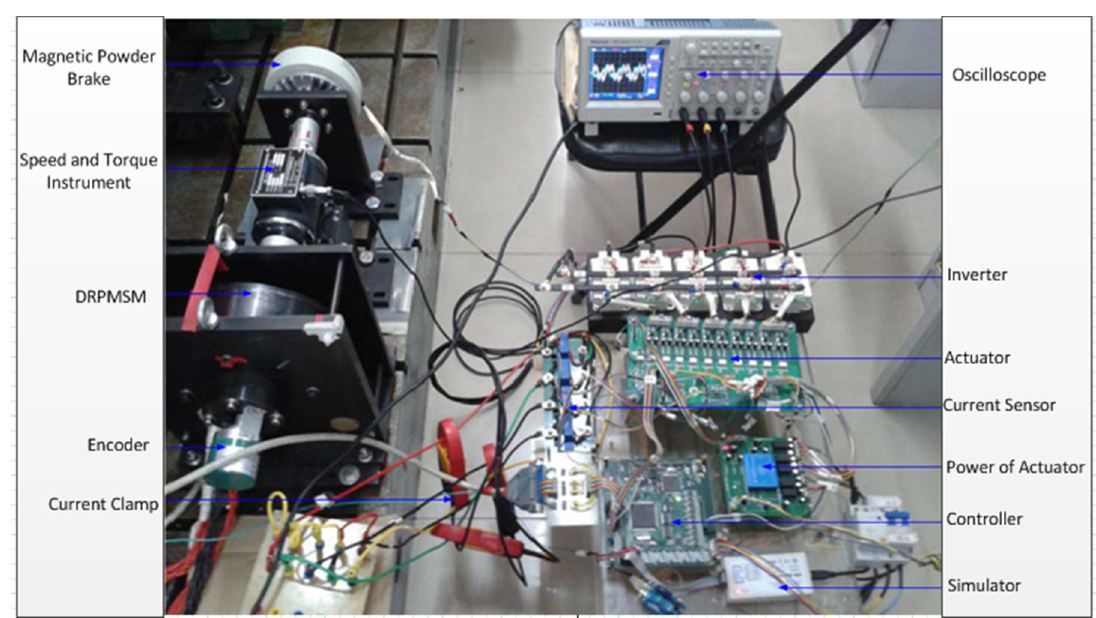
Figure 24. The drive circuit of DRPMSM.